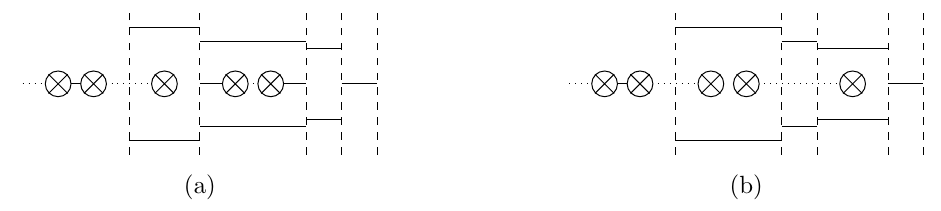
Figure 35. Brane realization of the B-collapse of partitions (3 ; 2) B = (3 ; 1 2 ). (a) Has interval numbers for the half NS5-branes ~k 0 = (0 ; 0 ; 1 ; 2 ; 2) corresponding to partition (cid:21) 0 = (3 ; 2). (b) Is obtained after performing the collapse transition on (a). The interval numbers of (b) are ~k = (0 ; 0 ; 1 ; 1 ; 3), corresponding to partition (cid:21) = (3 ; 1 2 ) = (cid:21) 0 . B